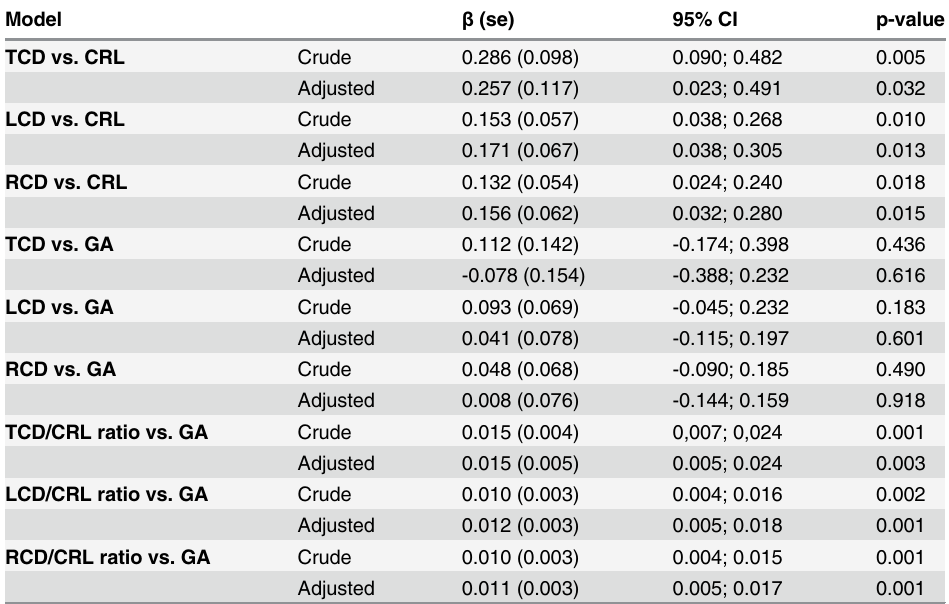
Crude and adjusted linear mixed models comparing effect estimates of preconceptional with postconceptional folic acid use of cerebellar growth trajectories. Estimates are depicted as embryonic cerebellar measurement (TCD, LCD and RCD) in mm per mm increase in CRL or days increase in GA. Crude model: Unadjusted model. Adjusted model, adjusted for designated confounders after stepwise backward elimination. TCD, transcerebellar diameter; LCD, left cerebellar diameter; RCD, right cerebellar diameter; CRL, crown-rump length; GA, gestational age; CI, con fi dence